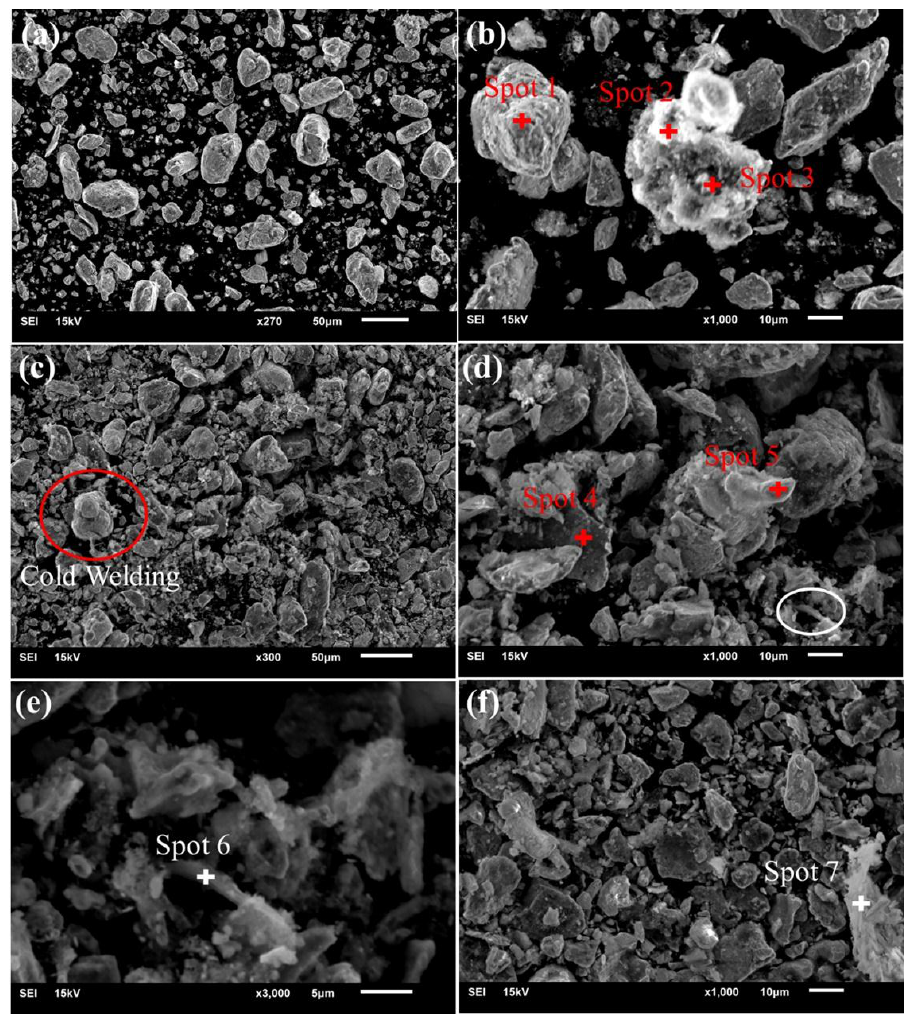
Figure 3. ( a , b ) Scanning electron microscope (SEM) micrographs of the 0.5-CNT snanocomposites in different regions; and ( c – e ) SEM micrographs of the 0.5-GNFs nanocomposites in different regions;